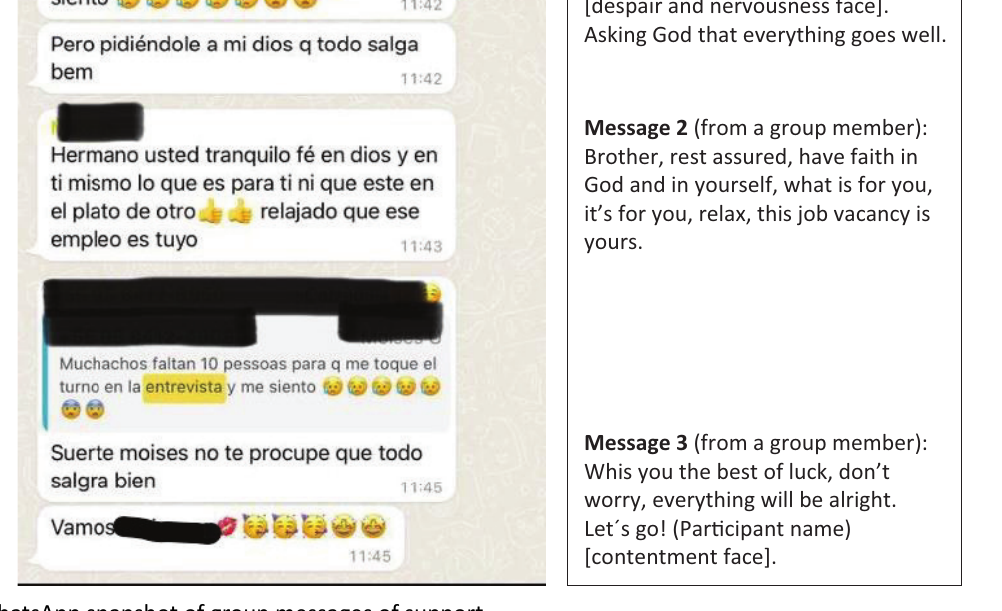
Figure 3. WhatsApp snapshot of group messages of